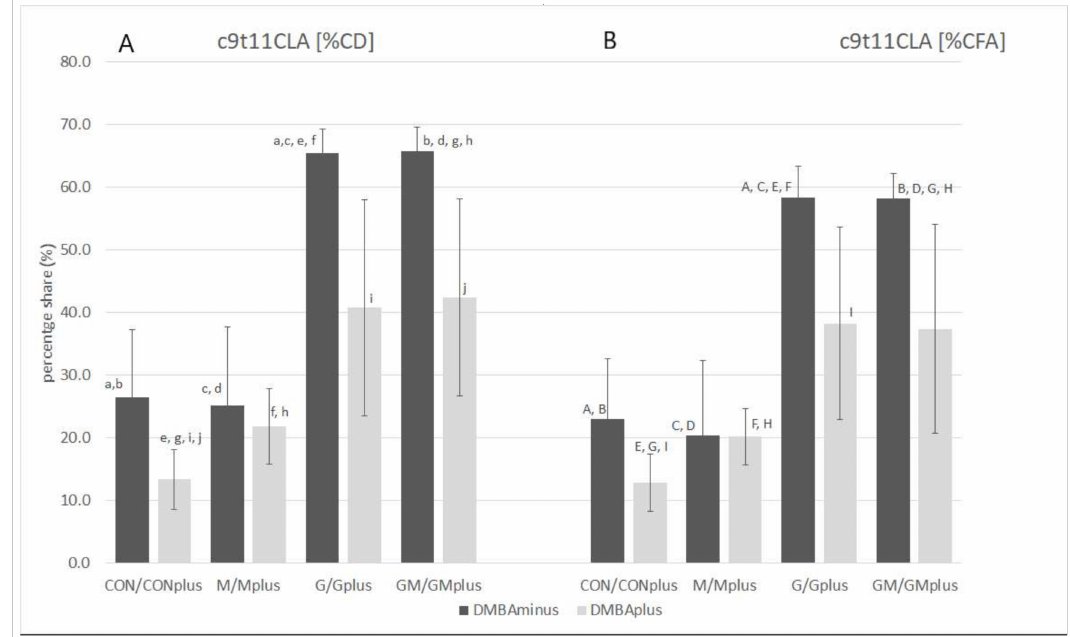
Figure 1. Percentage share of c9t11CLA in CD ( A ) and total CT ( B ) pool in hepatic microsomes of experimental groups. Data are shown as mean values ± standard deviation (SD). Variables marked with common letter indices (a–f and A–F) were significantly different according to Dunn’s test ( p < 0.05).